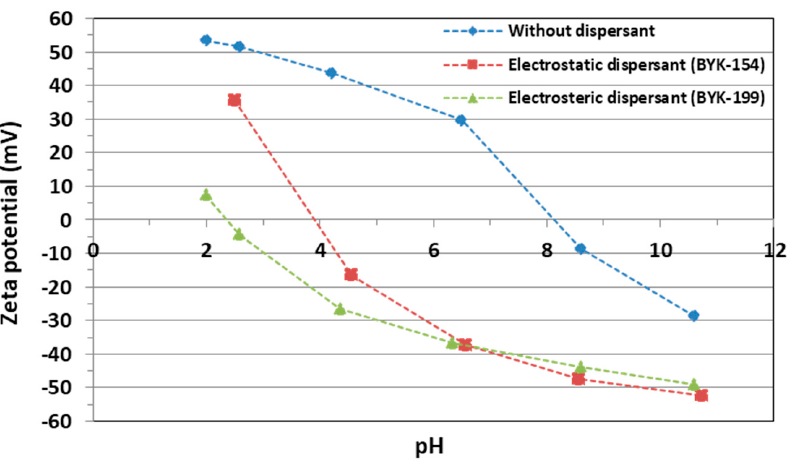
Figure 4. Zeta potential of Y 5 O 4 F 7 suspensions measured by ELS as a function of pH. To stabilize the aqueous Y 5 O 4 F 7 suspension and thereby to prevent the agglomeration of particles, two types of dispersants were used. One is the electrostatic dispersant (BYK- 154), which utilizes the electrostatic stabilization by the repulsive force of equally charged particles. The other is the electrosteric dispersant (BYK-199), which utilizes stabilization by the steric effects in addition to the electrostatic repulsion due to the presence of electric charges along the polymer chain